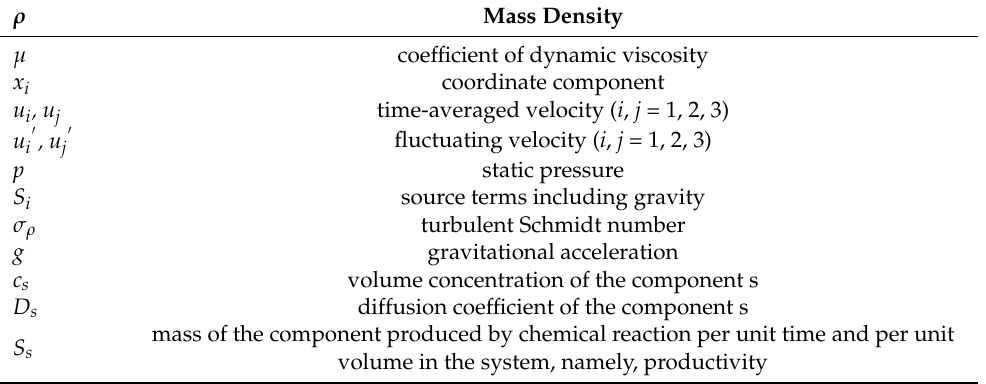
Table 1. Definition of the variables.